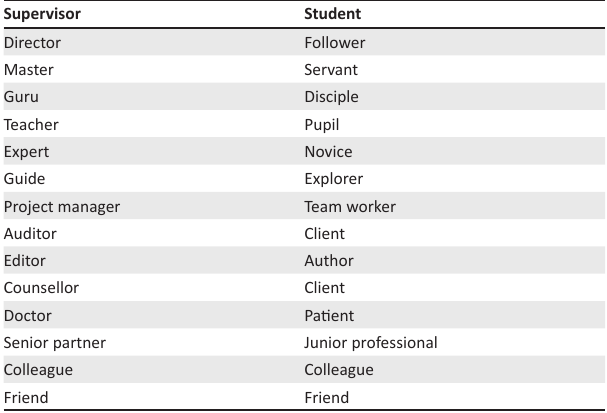
TABLE 1: Relationships between supervisors and